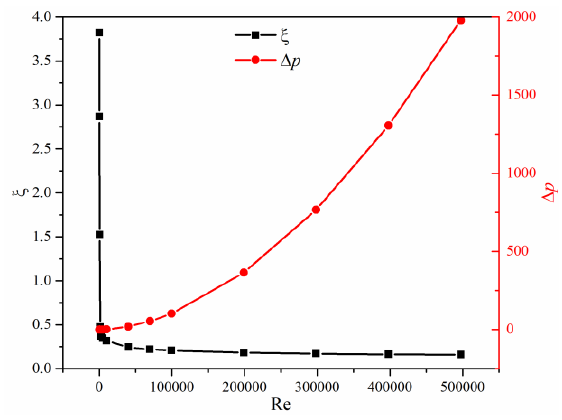
Figure 6. The pressure drop and the loss coefficient with different Reynolds number.